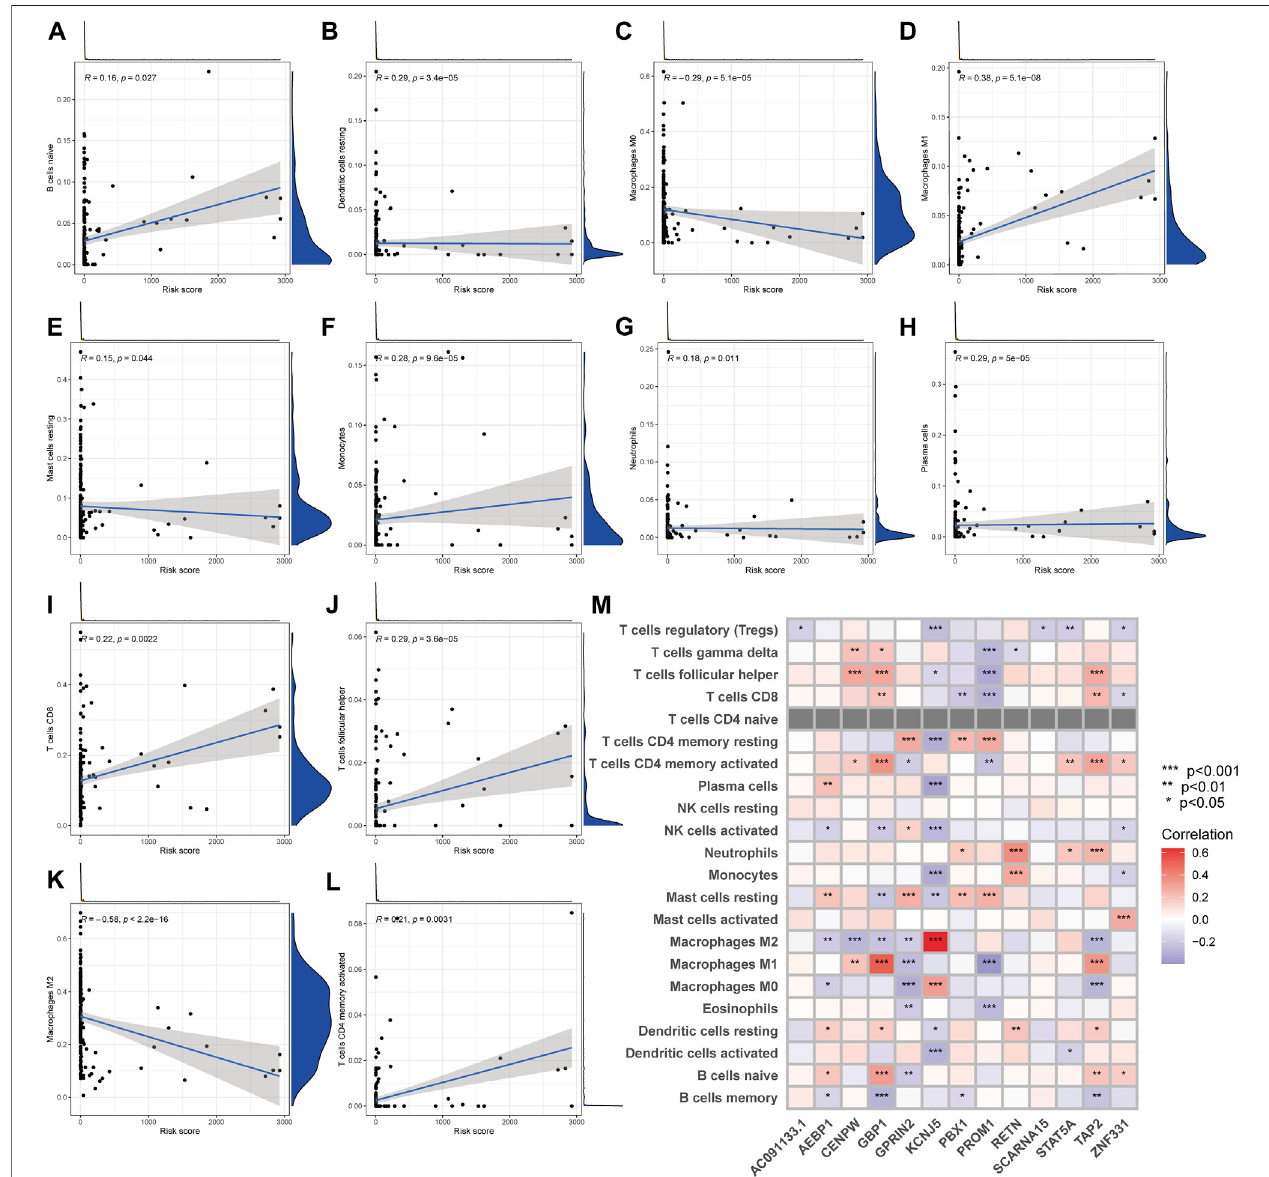
FIGURE 8 | TME comparison between the two subgroups. (A – L) The relationship between PRG score and immune cell type. (M) The relationship between the abundance of 22 immune cells and the abundance of 13 genes.